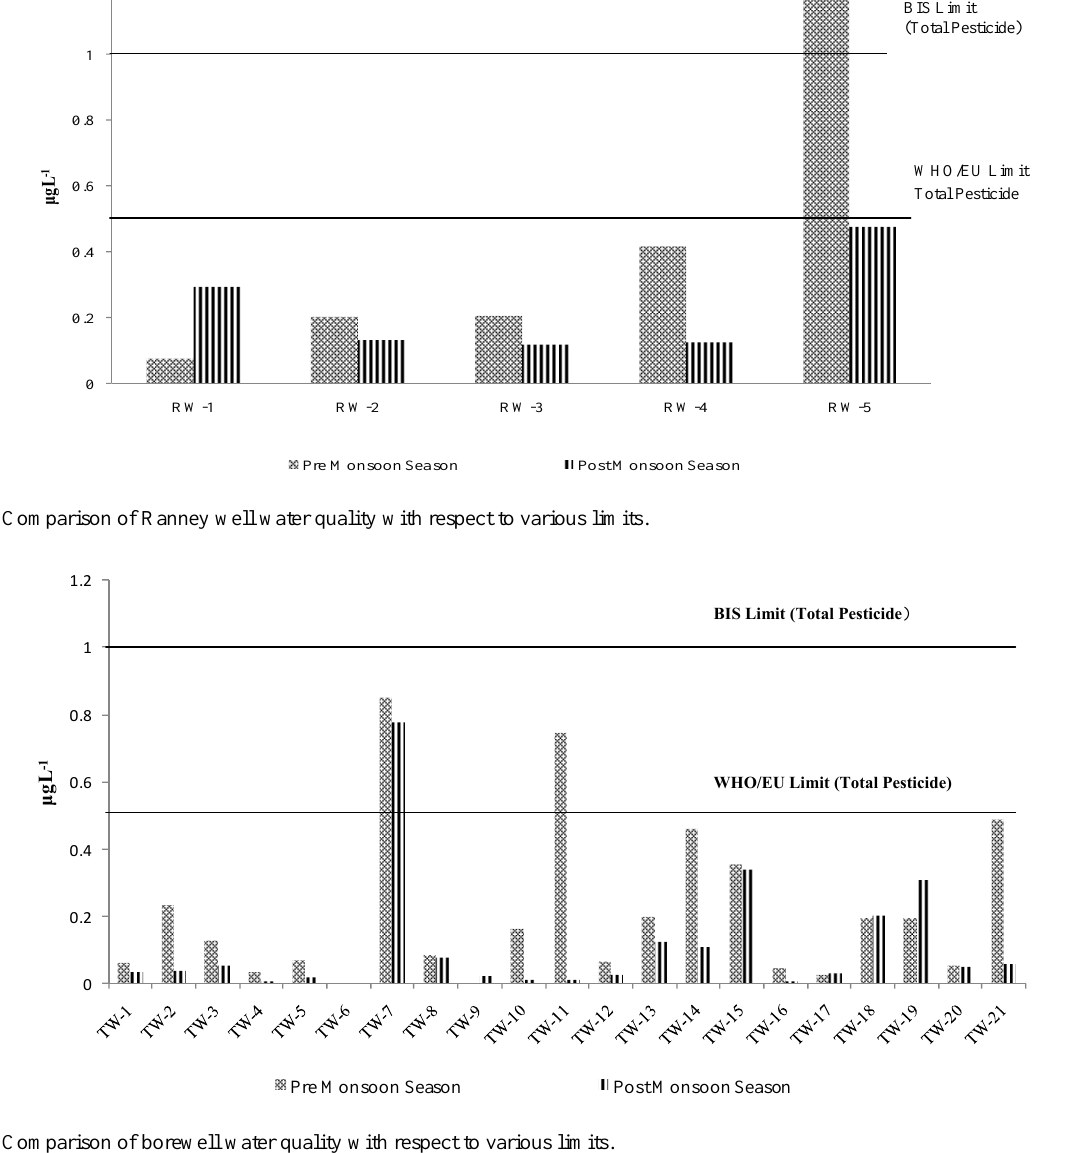
Figure 6. Comparison of Ranney well water quality with respect to various limits